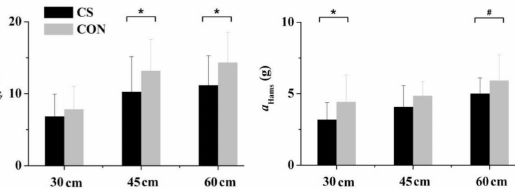
Figure 5. Compression effects on the maximum amplitude ( a ) of quadriceps femoris (QF) and hamstrings (Hams) at different drop heights of landings. * Significantly different from control shorts (CON) at the same landing height with p < 0.05; # different from CON at the same landing height with p < 0.1.